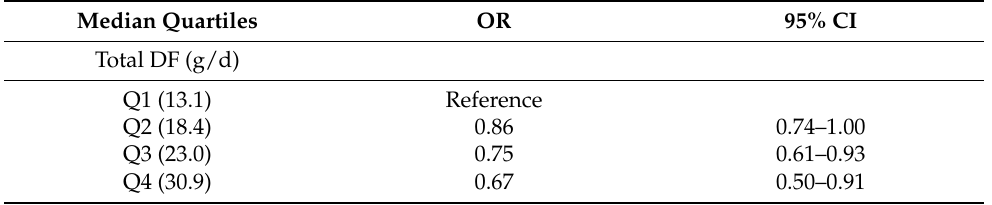
Table A3. Association of baseline intakes of total DF and RS, discretionary food-derived DF and RS and other food-derived DF and RS with 5 year MCS scores in 4067 Australian adults from the AusDiab study (excludes those with baseline MCS score < 47).